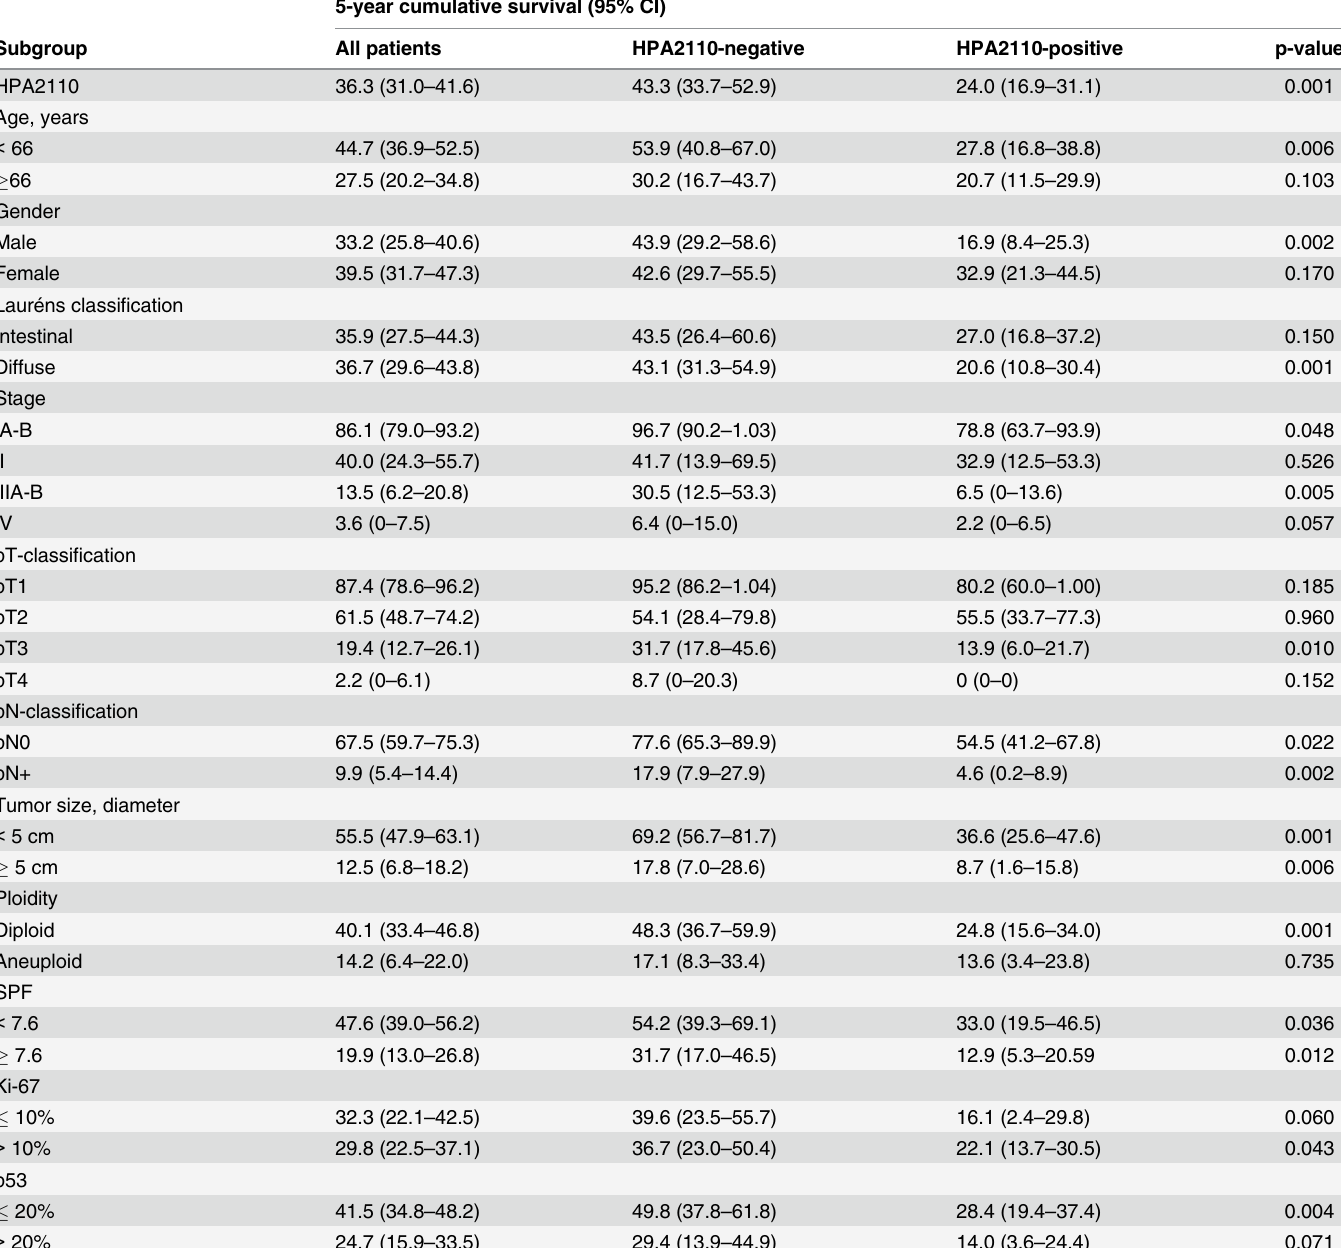
Table 3. Kaplan-Meier analysis for disease-specific survival stratified for subgroups of gastric cancer